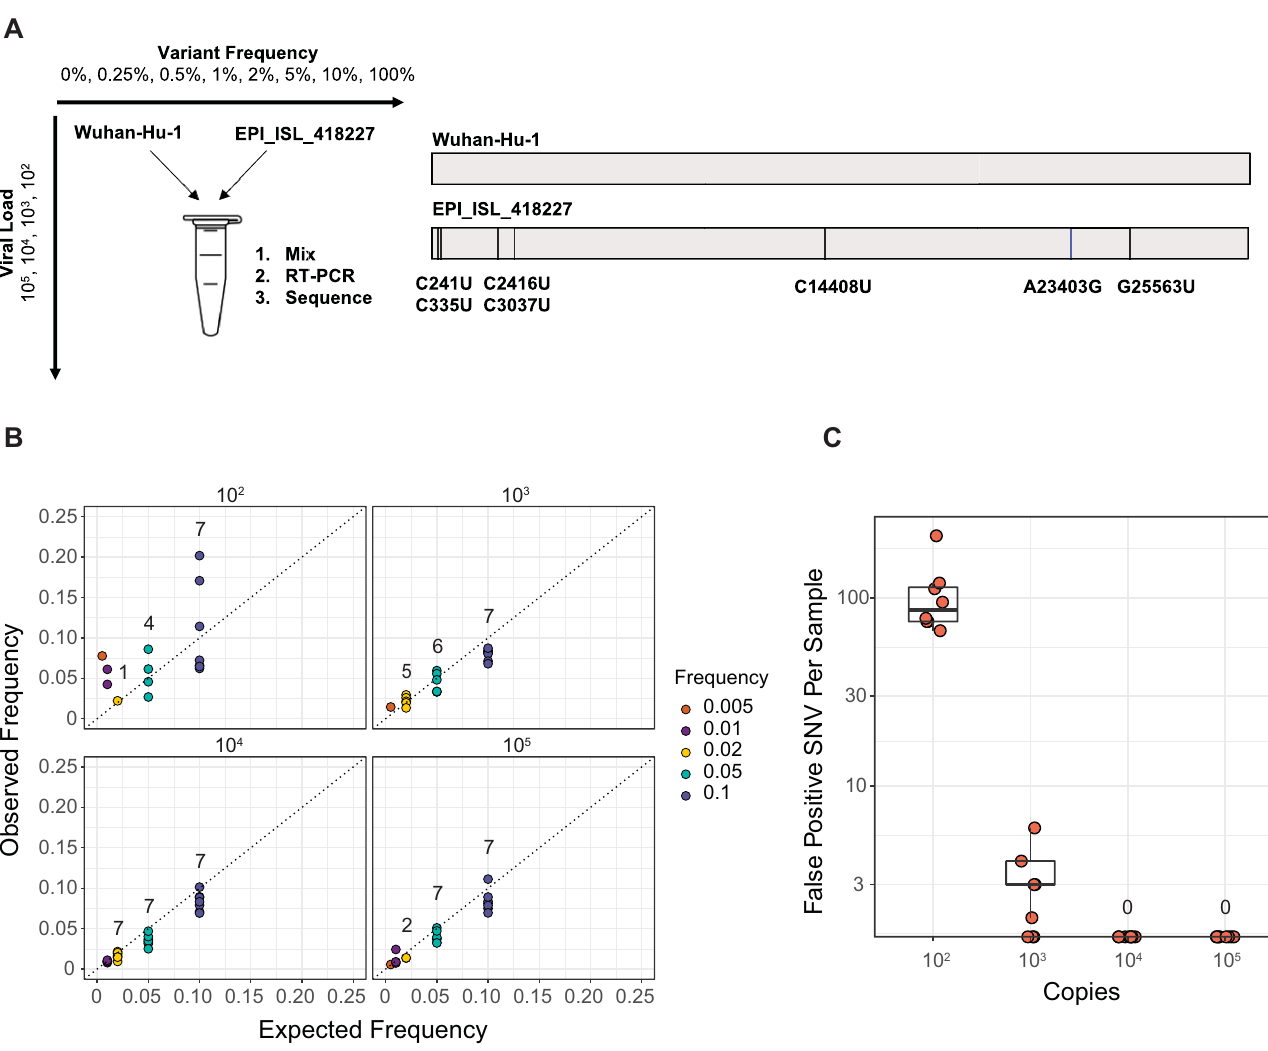
Fig 2. Assessing accuracy of intrahost variant detection by sequencing defined viral mixtures. (A) Schematic of the experiment. Wuhan-Hu-1 (reference) and EPI_ISL_418227 (variant) RNA were mixed at the given frequencies and viral loads (units of genome copies per microliter, representing the resulting mixture). Mixtures of RNA were amplified and sequenced in the same fashion as the clinical specimens. Reference and variant genomes differ by seven single nucleotide substitutions. (B) Observed frequency by expected frequency. Observed frequency of the true positive intrahost single nucleotide variants (iSNV) is on the y-axis and expected iSNV frequency is on the x-axis. Synthetic RNA copy number in units of genome copies per microliter of RNA is shown above each facet. Values above the points indicate the number of variants detected in that group (maximum of seven per group). (C) False positive iSNV. Number of false positive iSNV per sample is shown on the y-axis (base 10 log scale) and viral load as shown in (B) is on the x-axis, excluding iSNV at positions 3350, 6669, 13248, and 13419. Each point represents a unique sample and the boxplots represent the median and 25 th and 75 th percentiles, with whiskers extending to the most extreme point within the range of the median ± 1.5 times the interquartile